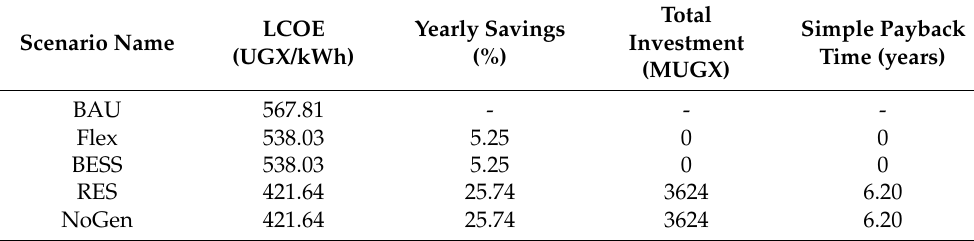
Table 8. Summary of economic results with a lower price of